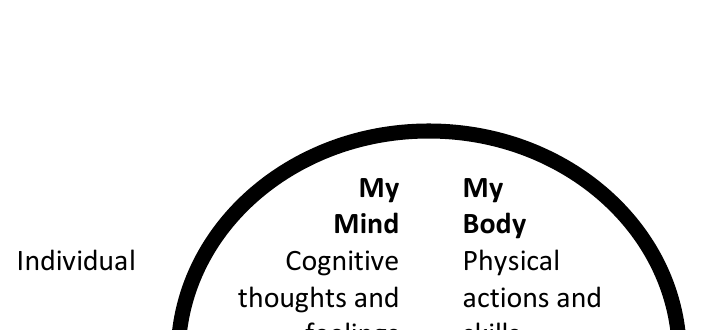
Figure 1. The Integral Play